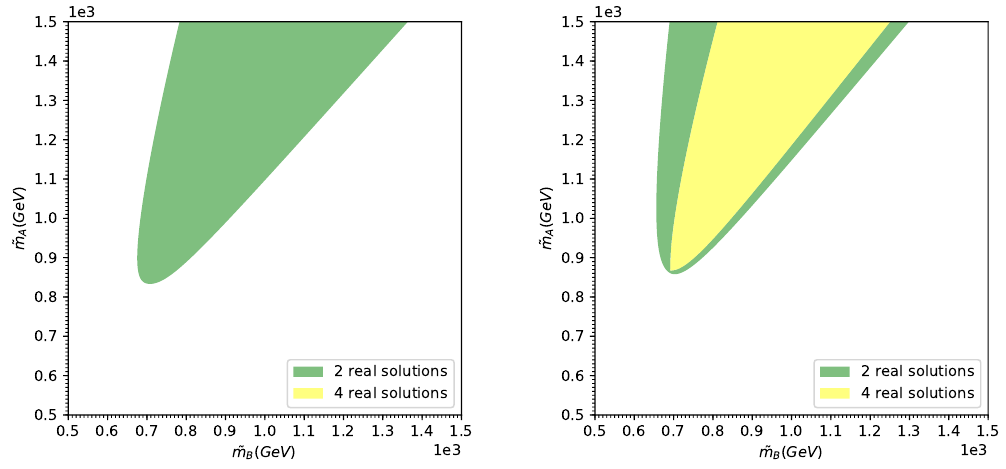
Figure 3 . The same as (cid:12)gure 2, except the trial mass ~ m is now chosen to be smaller than the C true mass: ~ m = 600 GeV < m . Since ~ m is di(cid:11)erent from m , the true mass point is not seen in C C C C these plots.